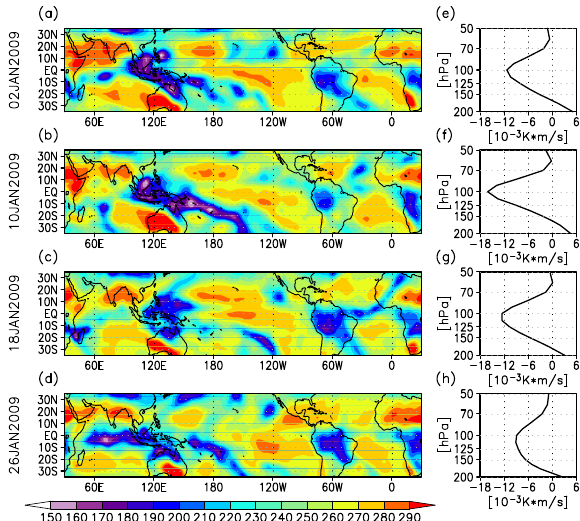
Fig. 12. (left) Maps of OLR (Wm − 2 ) and (right) vertical profiles of the vertical heat flux w 0 θ 0 (Kms − 1 ) averaged over 10 ◦ S–10 ◦ N. (a, e) 2 January 2009, (b, f) 10 January 2009, (c, g) 18 January 2009, and (d, h) 26 January 2009. Data are smoothed using a 5-day running average.